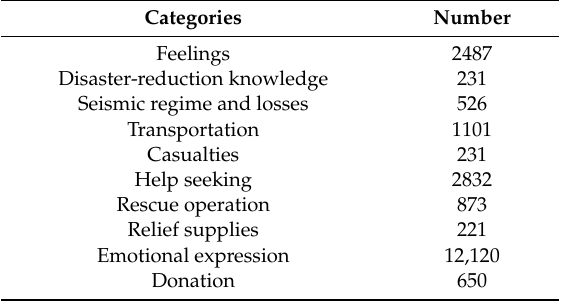
Figure 6. Temporal variation ( a ) and spatial distribution ( b ) of the quantity of the types of information. The percentage of each type of information was calculated per day. In addition, the pie charts show the types in different prefecture-level cities. Table 3. Number of microblogs per category in the seven days after the earthquake.